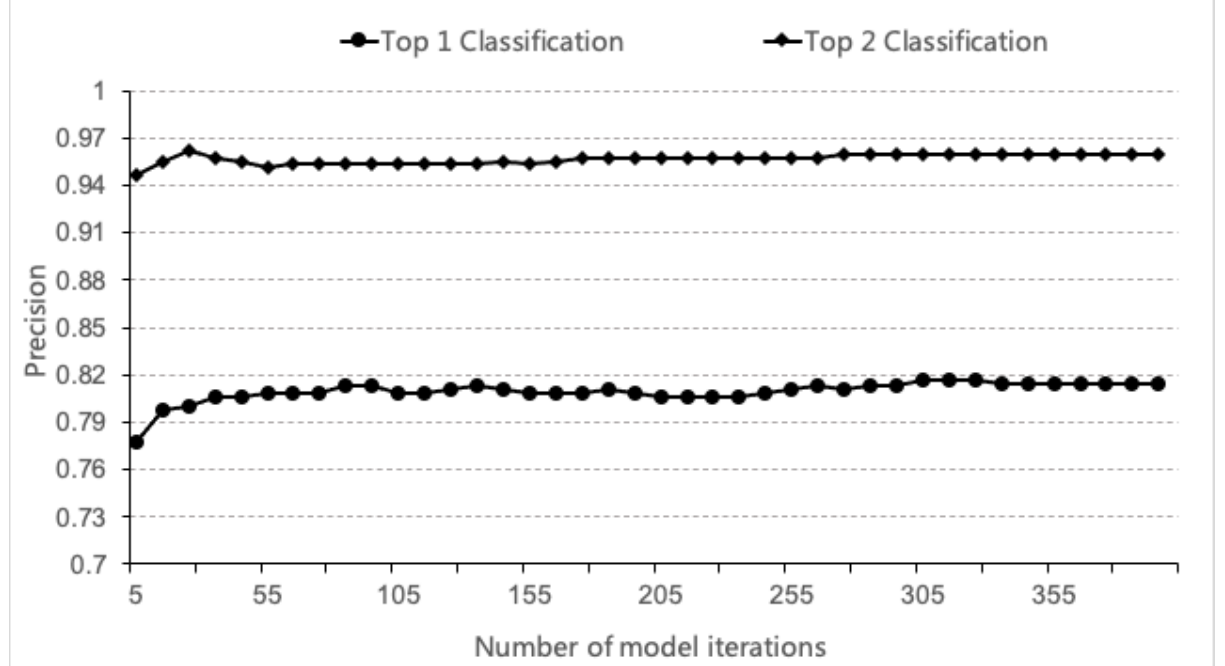
Figure 6. Performance of top 1 and top 2 classifications.